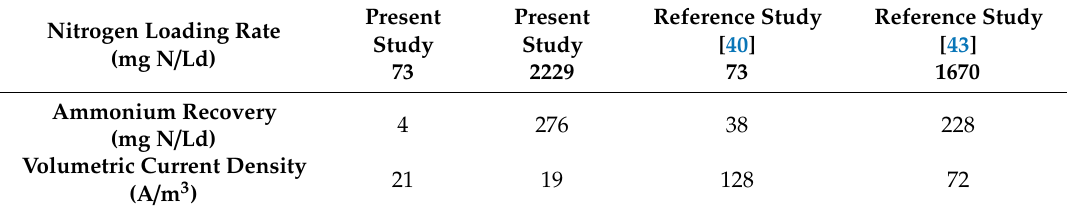
Table 6. Performance comparison of the tubular MEC with previous literature data for the ammonium